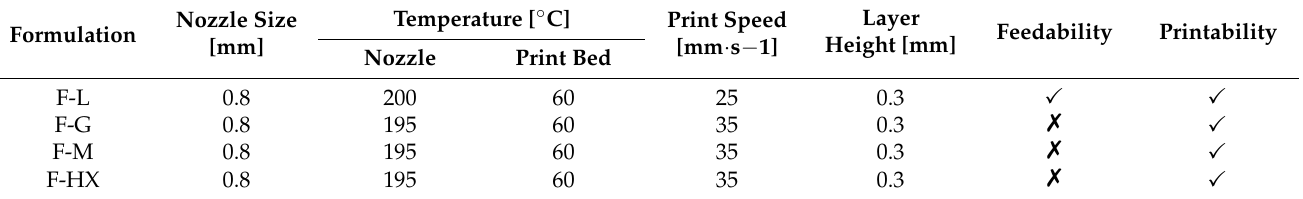
Figure 2. Mechanical properties of extruded filaments. Breaking distance and breaking stress were determined in a three-point-bend test ( n = 5). Data are presented as mean ± standard deviation. Table 4. 3D-printing parameters for each formulation of 3D-printed tablets including results regarding feedability and printability of the filaments.